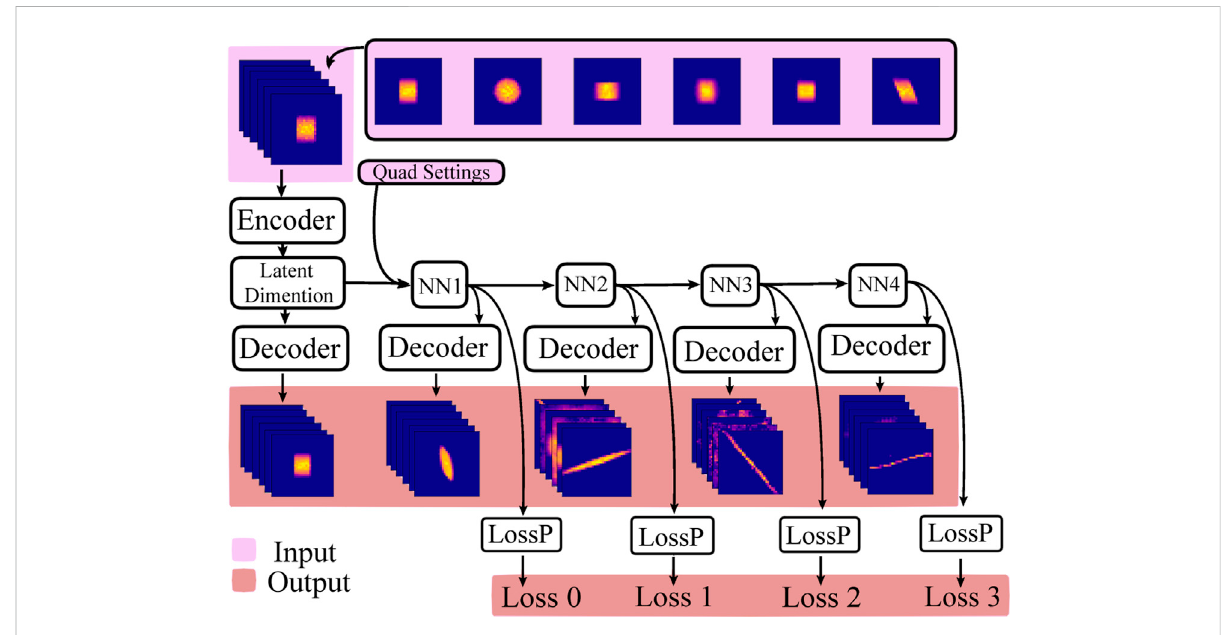
FIGURE 2 Cartoon of architecture. During training, the model takes all the 2D projections and loss value as input into the training. Only the initial 2D projections were given during testing, and the model predicts the loss values and 2D projections in